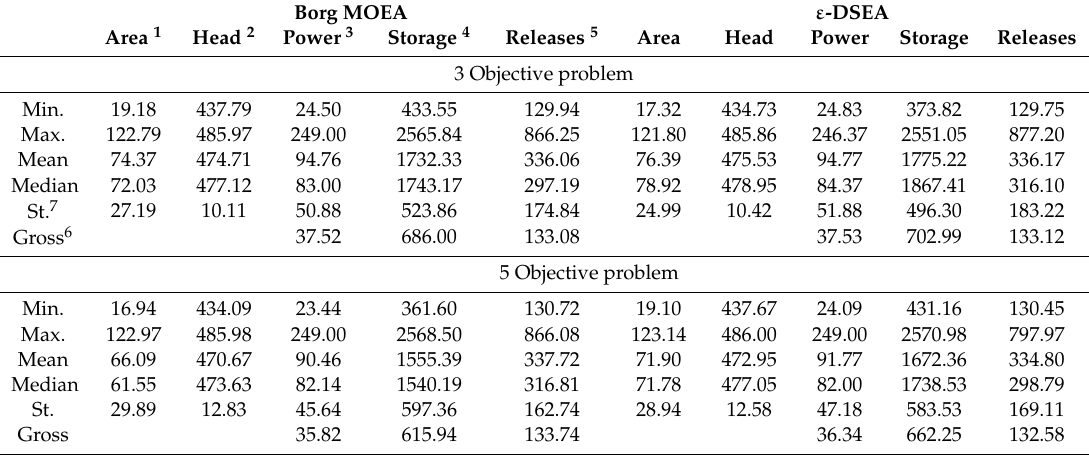
Table 3. Results’ analysis of water resources management strategy of Derbendikhan dam achieved by both algorithms based on maximising hydropower generation.